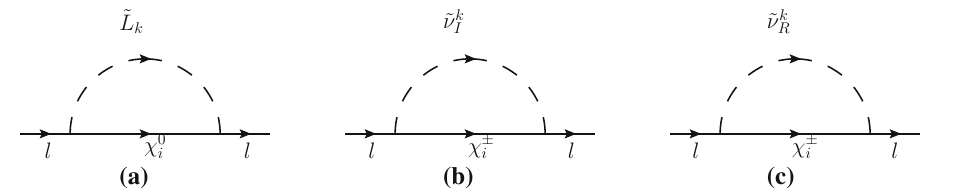
Fig. 1 The one-loop self energy diagrams affect lepton MDMs in the U ( 1 ) X SSM. The triangle diagrams can be obtained by attaching a photon